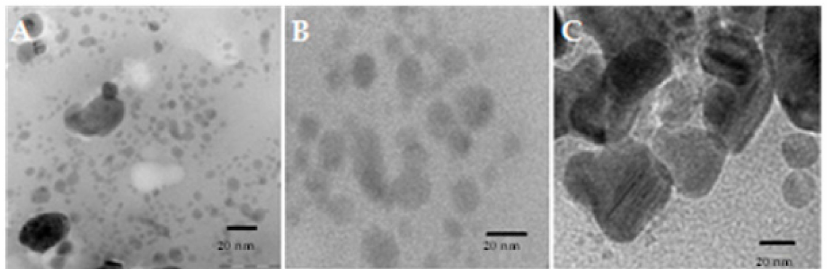
Figure 5. Images of Transmission electron microscopy (TEM) of synthesized ZnNPs ( A – C ) showing spherical or globular ( B , C ) shaped with the undefined varied size of 52-70 nm. Bar scale—20 nm.